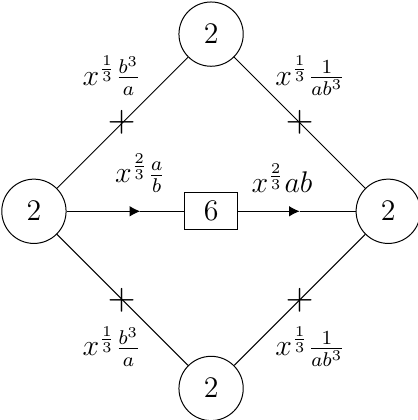
Figure 7 . The 3 d quiver theory associated with the compactification of the 5 d E 7 SCFTs on a √ torus with flux ( 2; 0 , 0 , 0 , 0 , 0 , 0) . In the figure we have used fugacities to represent the charges of the fields under the global symmetries, specifically, the fugacities a and b for the two U(1) global symmetries and x for the R-symmetry. The theory also contains various superpotential interactions, which corresponds to all operators build from the fields that carry R-charge 2 and are global symmetry singlets. For completeness, we note that these include the two quartic superpotentials running along the upper and lower triangles, the flipping superpotentials and the four monopole superpotential of the type (1 , 1) for all adjacent SU(2)